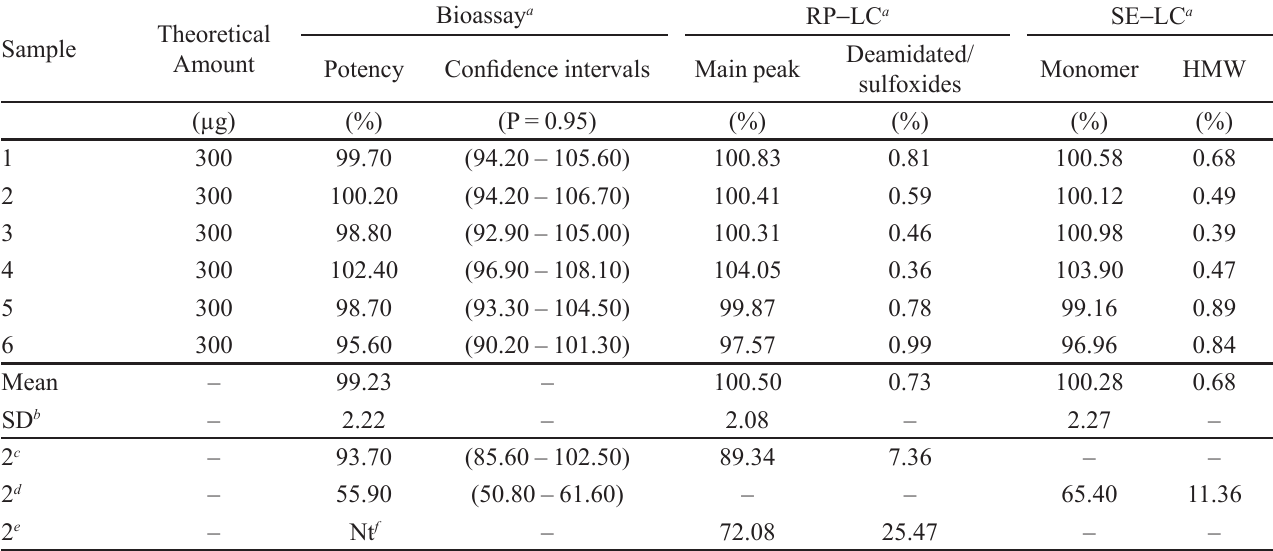
TABLE IV - Comparative content/potency evaluation of rhIFNβ − 1b in biopharmaceutical formulations by bioassay and LC methods